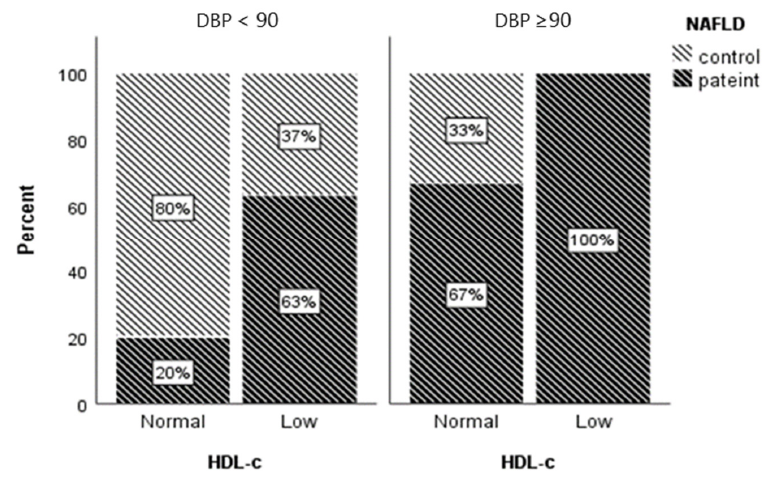
Figure 1. Percentage of NAFLD patients in DBP and HDL groups. Low HDL-c (<1.04 mmol/L for men and < 1.3 mmol/L for women). men and <1.3 mmol/L for